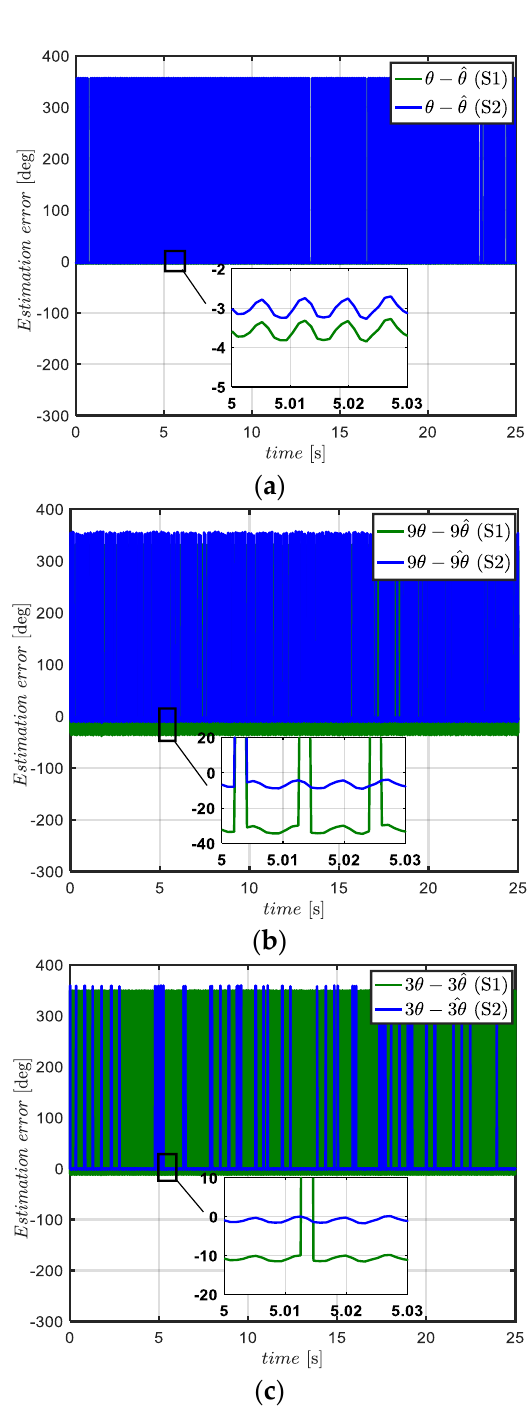
Figure 25. Experimental waveforms: position errors resulting from ( S1 ) and ( S2 ): ( a ) error on the angle required to control MM, ( b ) error on the angle required to control SM, ( c ) error on the angle required to control TM. Table 5. Resulting position error (electrical angle) from strategies ( S1 ) and ( S2 ) .